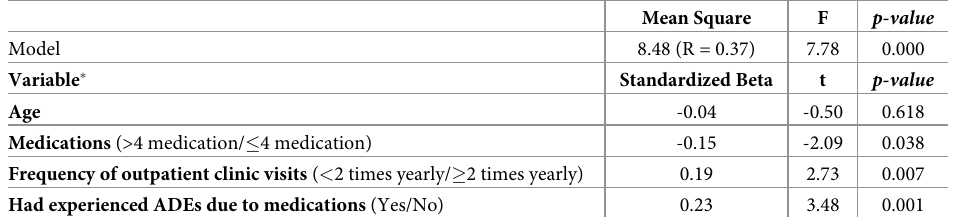
Table 7. Multivariate linear regression results for factors affecting the scores of MGL